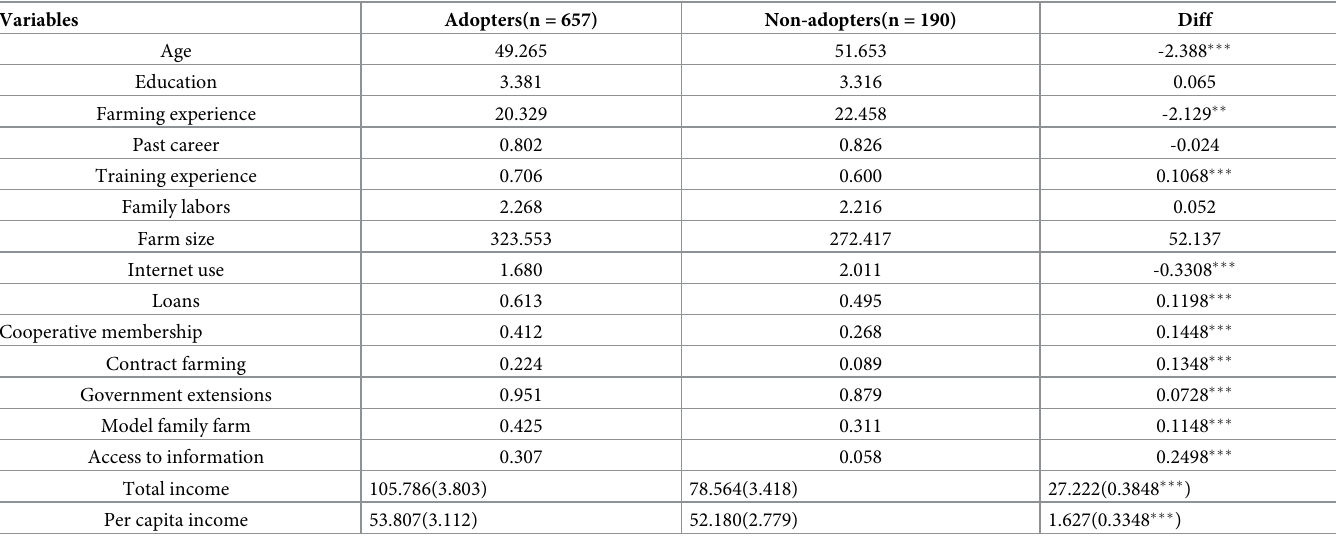
Table 5. Mean differences in characteristics between new technology adopters and